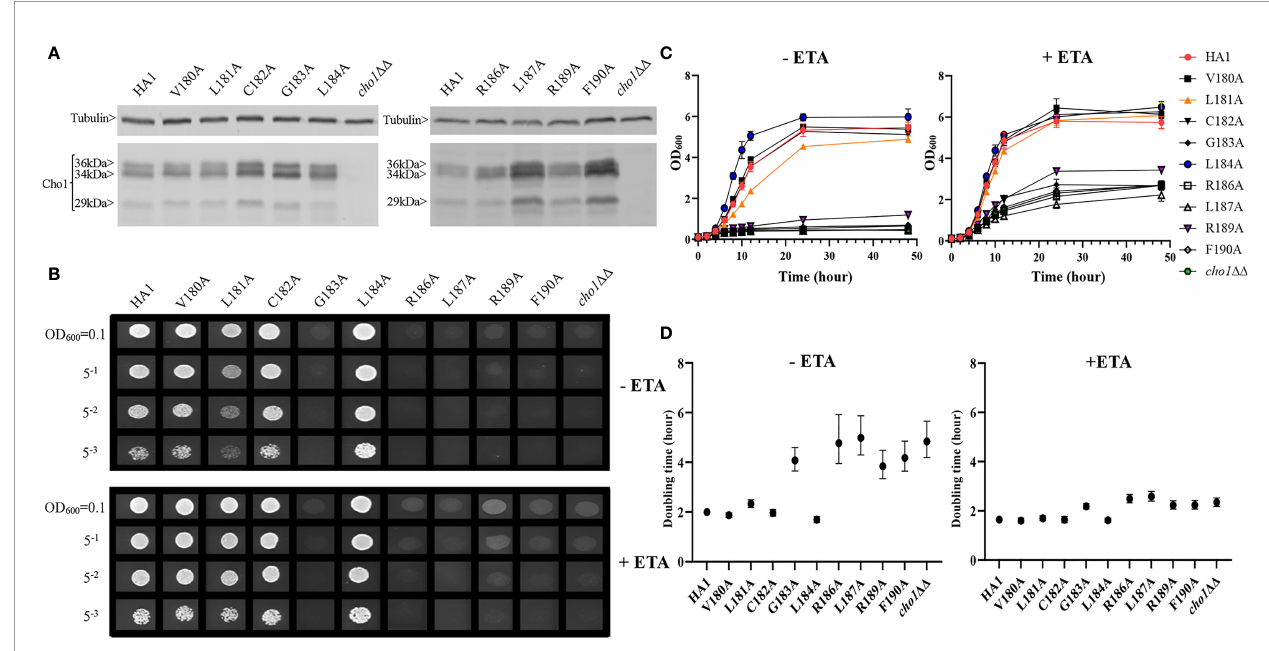
FIGURE 6 | Mutations in the putative serine binding site reduce in vivo Cho1 function. (A) Cho1 expression from cho1 DD , HA1 and each of the putative serine binding site mutants was checked using western blotting. In vivo activities were measured in (B) spot dilution assays and (C) growth curves. (D) Doubling times for each strain were calculated from growth curves. Error bars represent the 95% asymmetrical (pro fi le-likelihood) con fi dence intervals of each doubling time from a total of six replicates. (+ETA, minimal medium+1 mM ethanolamine; -ETA, minimal medium).